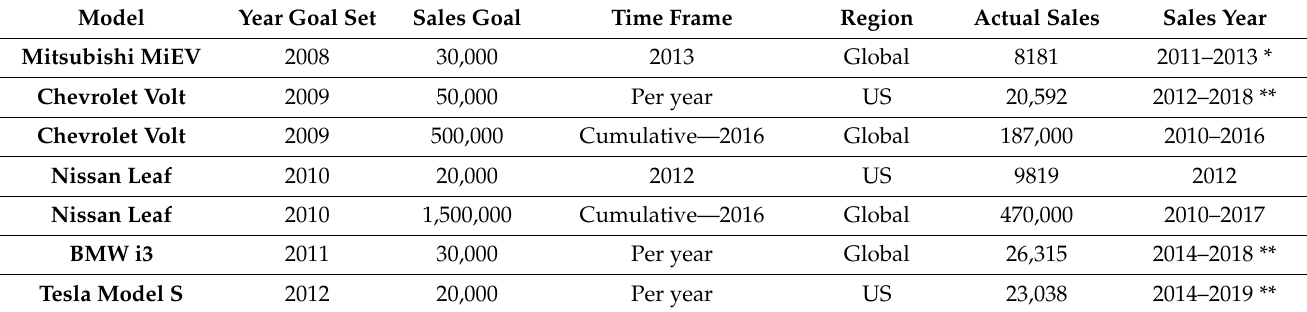
Table 1. First-Generation Modern PEVs: Sales Targets vs. Actual Sales [5] (p. 35).